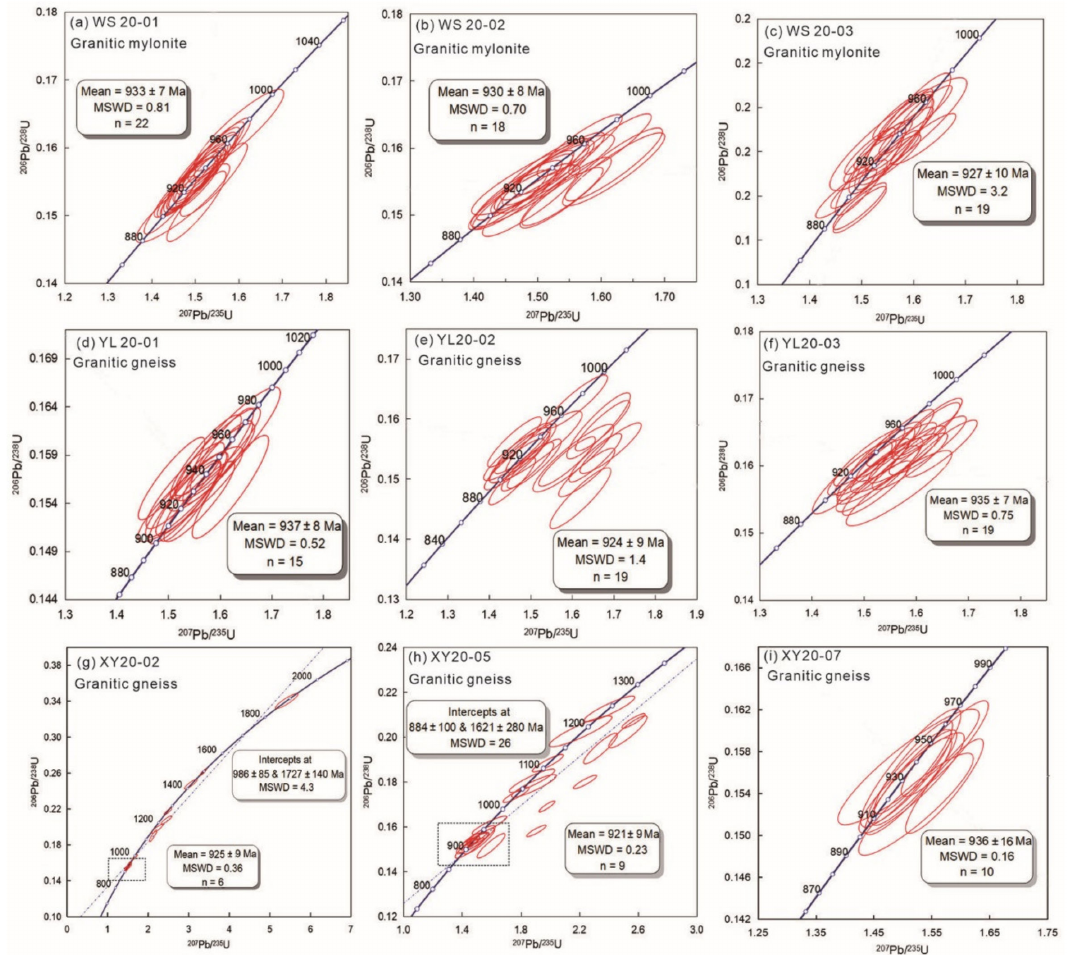
Figure 7. LA–ICP–MS zircon U–Pb concordia diagrams for the granitic mylonites from Wushan ( a – c ) and granitic gneisses from Yuanlong ( d – f ) and Xinyang ( g – i ) in the western margin of the NQT. Xinyang Granitic